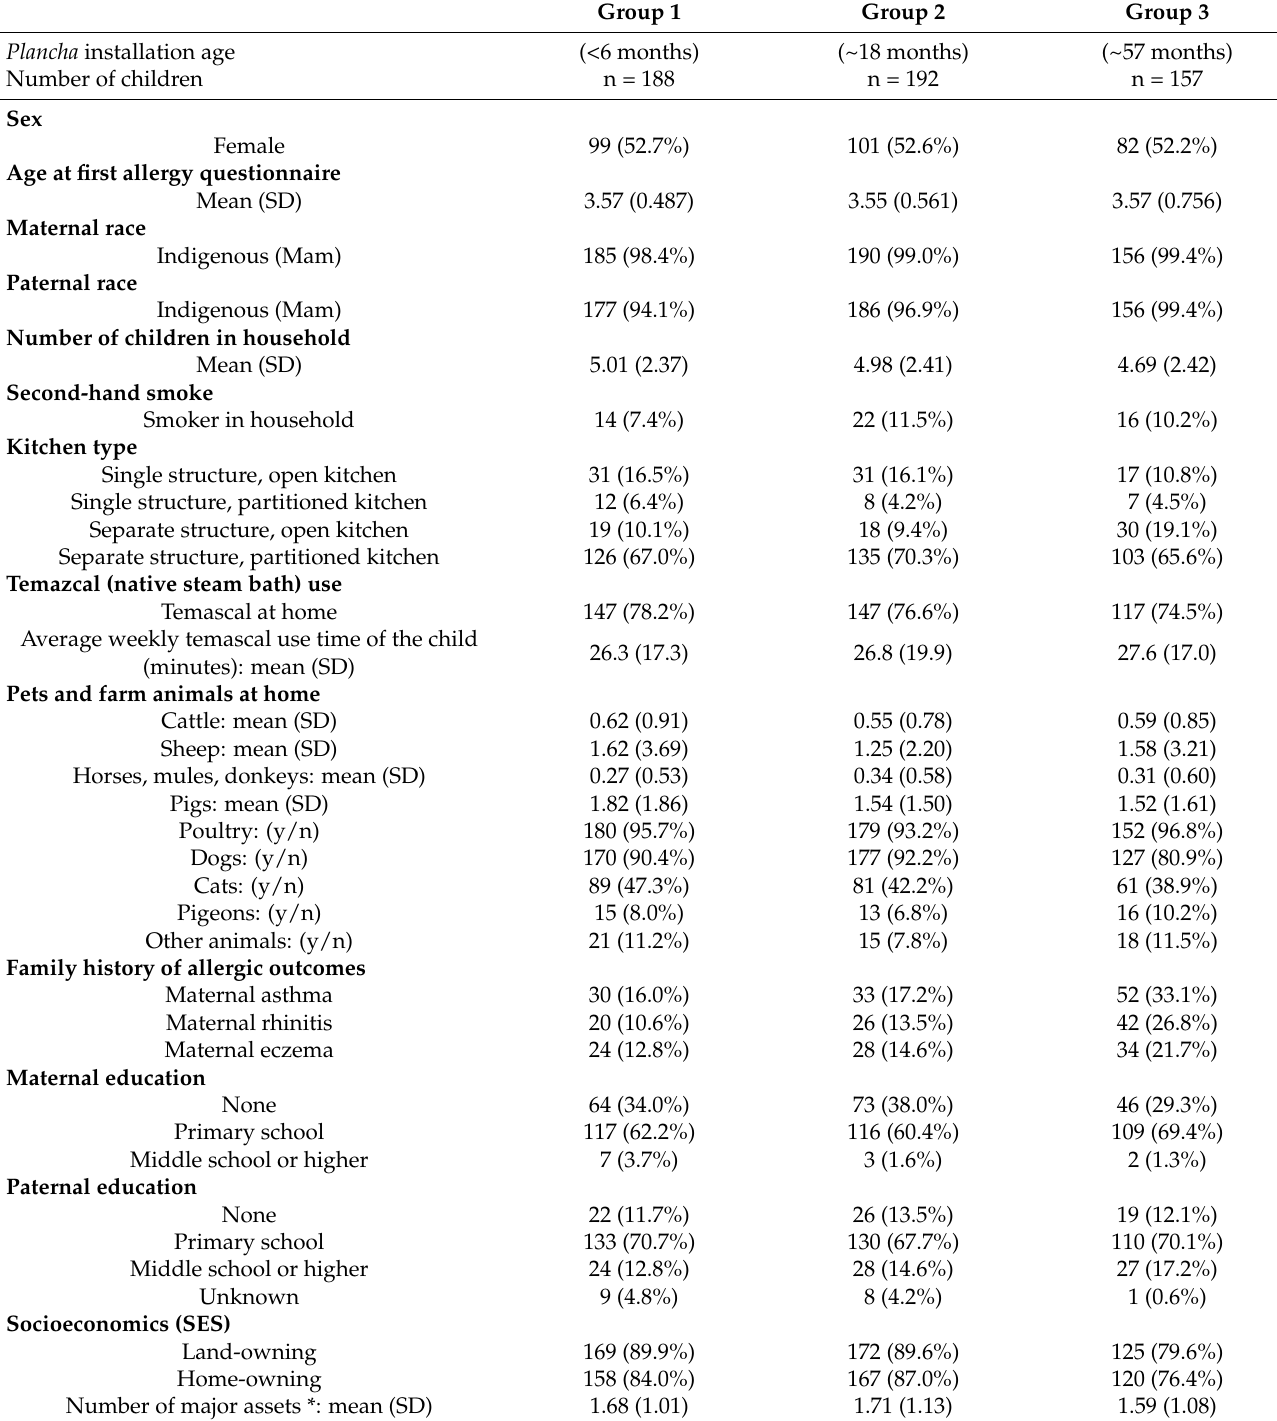
Table 1. Household-level and child-level demographic characteristics by study group. Group 1 Group 2 Group 3